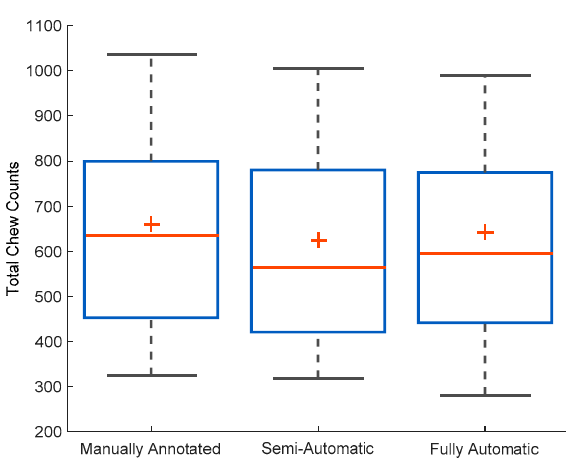
Figure 6. Box plots for total number per meal by human annotation; algorithm estimation with manually annotated, semi-automatic approach and fully automatic approaches. Table 1. Details about the duration, number of bites, chews, swallow, and mass in grams for different meal types. Breakfast Lunch Mean Duration s